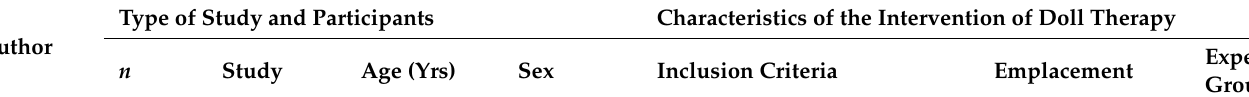
Table 1. Characteristics of the studies included in the systematic